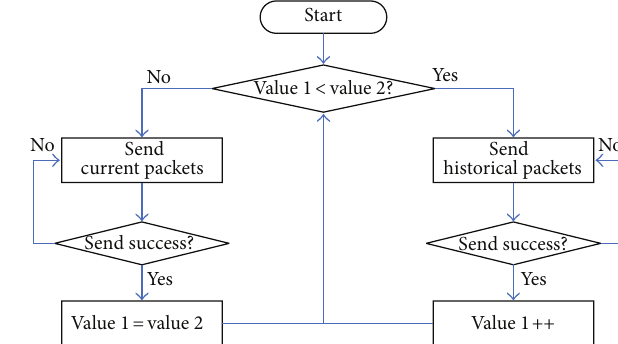
Figure 7: Flow chart of